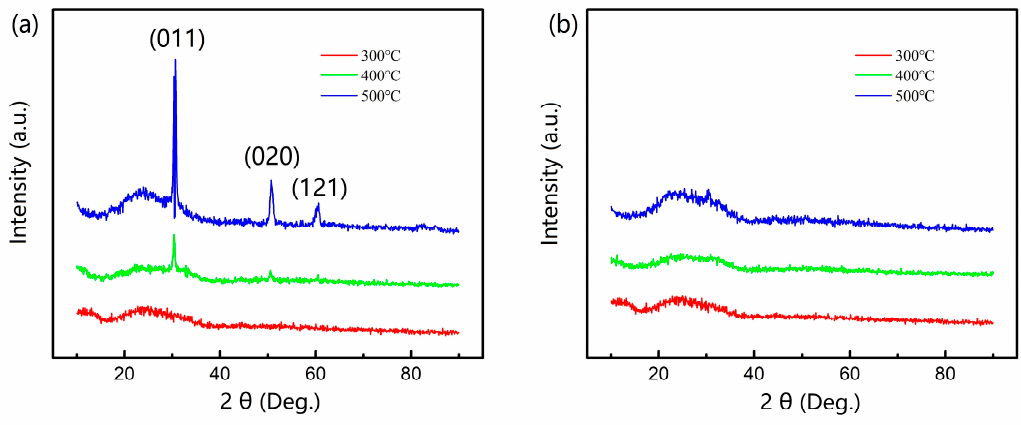
Figure 2. XRD spectra of ZrO 2 films with different post-annealing temperatures. ZrO 2 film of ( a ) 67 nm and ( b ) 130 nm.